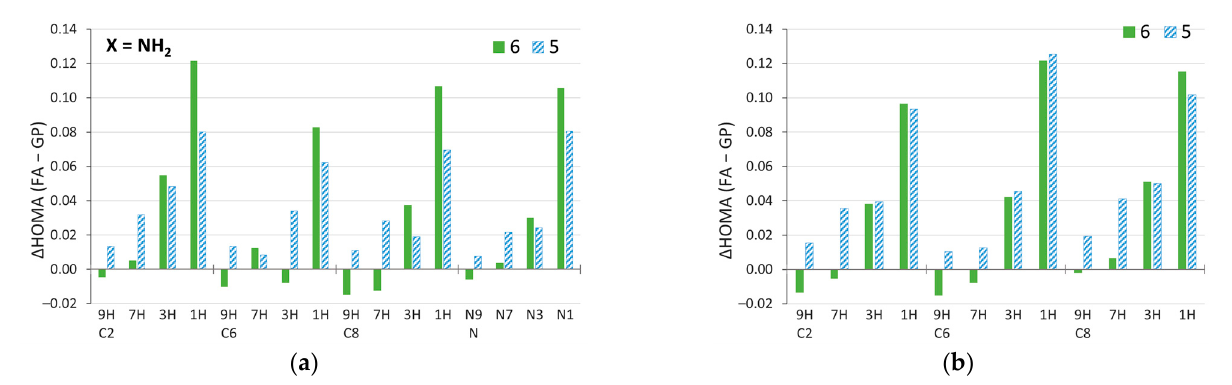
Figure 9. Changes in HOMA index due to solvation Δ HOMA (FA–GP), calculated by subtracting the value in the gas phase from the value in the most polar solvent considered, formamide. Data for the ( a ) amino and, for comparison, ( b ) nitro derivatives [59].